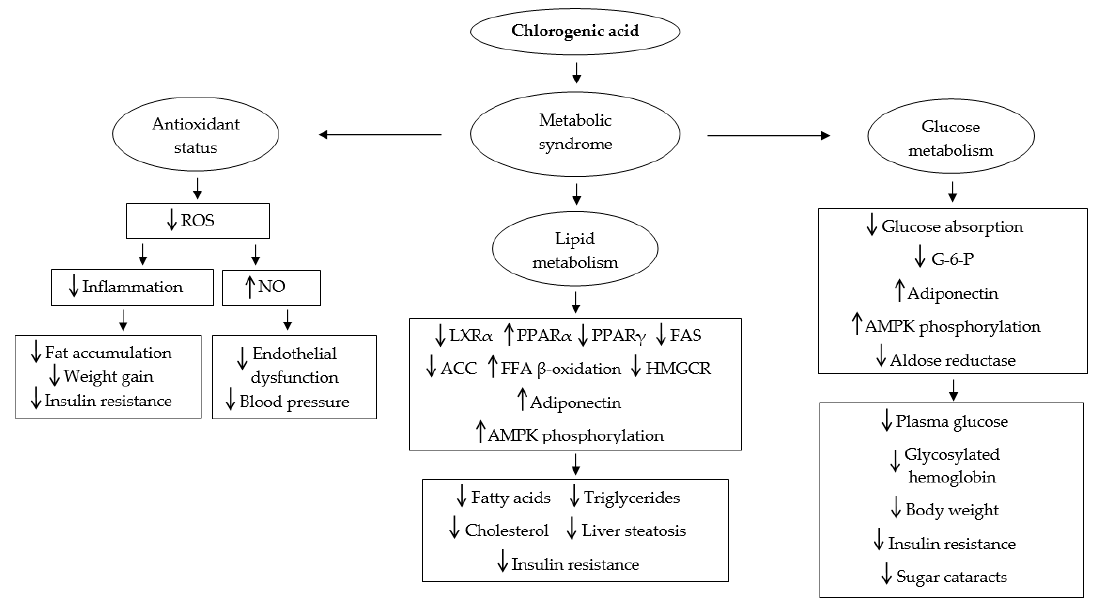
Mechanisms of action of chlorogenic acid over metabolic syndrome. Abbreviations: ACC = acetyl-CoA carboxylase, AMPK = AMP-activated protein kinase, FAS = fatty acid synthase, FFA = free fatty acid, G-6-P = glucose-6-phosphatase, HMGCR = 3-hydroxy-3-methylglutaryl CoA reductase, LXR α = liver X receptor α , NO = nitric oxide, PPAR α = peroxisome proliferator-activated receptor α , PPAR γ = peroxisome proliferator-activated receptor γ , ROS = reactive oxygen species.